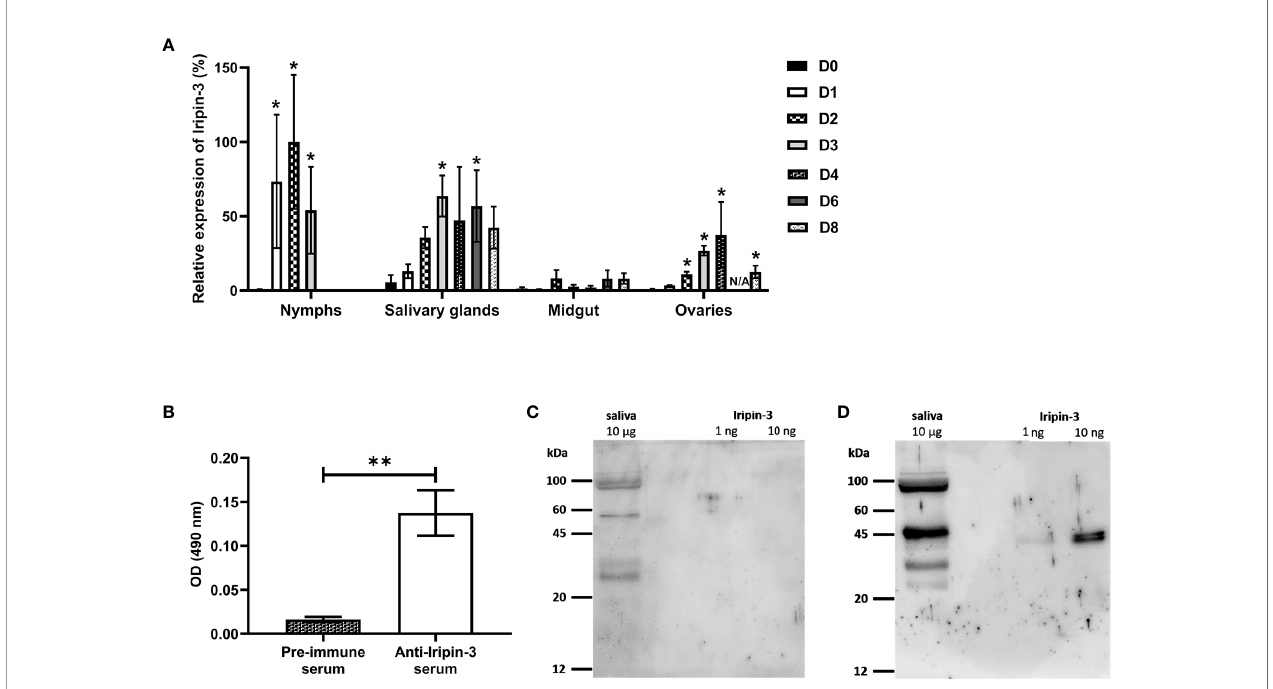
FIGURE 4 | Iripin-3 transcription in I . ricinus ticks is increased in response to blood feeding, and Iripin-3 protein is present in the saliva of feeding ticks. (A) Iripin-3 mRNA expression in nymphs and in the salivary glands, midguts and ovaries of adult females feeding for 1 (D1), 2 (D2), 3 (D3), 4 (D4), 6 (D6), and 8 (D8) days or not feeding at all (D0). In nymphs, the last column represents fully engorged ticks that completed their blood meal in 3 or 4 days. N/A – data not available. Relative expression values were calculated using the DD Ct (Livak) method (60), with rps4 serving as a reference gene. A group with the highest iripin-3 expression (nymphs feeding for 2 days) was utilized as a calibrator during calculations, and its expression value was set to 100%. Data are presented as mean of three biological replicates ± SEM. Statistically signi fi cant induction (p < 0.05) of iripin-3 expression as compared to unfed ticks is marked with an asterisk. (B) ELISA results expressed as optical density (OD) values measured after exposure of tick saliva to either rabbit pre-immune serum or rabbit antiserum to Iripin-3. Data are presented as mean ± SEM of three values (**p < 0.01). (C, D) Tick saliva (10 m g) and Iripin-3 (1 ng or 10 ng) were resolved by SDS-PAGE and transferred to PVDF membranes. The membranes were incubated with rabbit pre-immune serum (C) or rabbit antiserum to Iripin-3 (D)